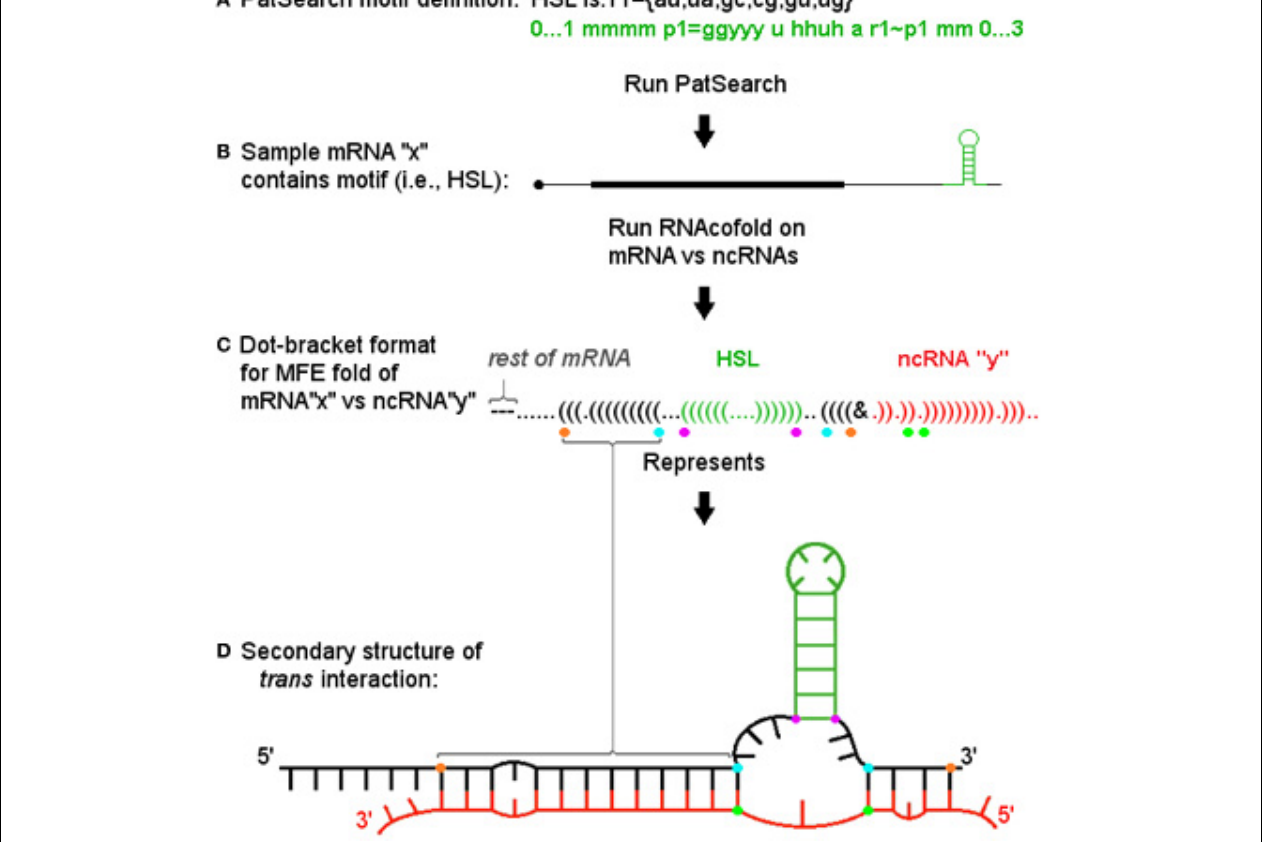
are denoted by colored dots below corresponding dot-bracket characters. Purple dots denote bottom bases of motif stem. Blue dots denote first mRNA base hybridized to ncRNA 5 (cid:2) and 3 (cid:2) of the motif. Orange dots denote last mRNA bases hybridized to ncRNA 5 (cid:2) and 3 (cid:2) of motif (where “first” and “last” are relative to distance from motif base). The green dots denote the ncRNA bases paired with the blue dot mRNA bases. (D) The secondary structure described by the dot-bracket notation is shown. Colored dots identified in previous section are shown at their corresponding base positions. The segments they define can be easily identified in this format. Segments between purple and blue dots define the mRNA side junction regions. Segment between green dots defines the ncRNA side junction region. Segments between blue and orange dots define extent of 5 (cid:2) and 3 (cid:2) helices on mRNA